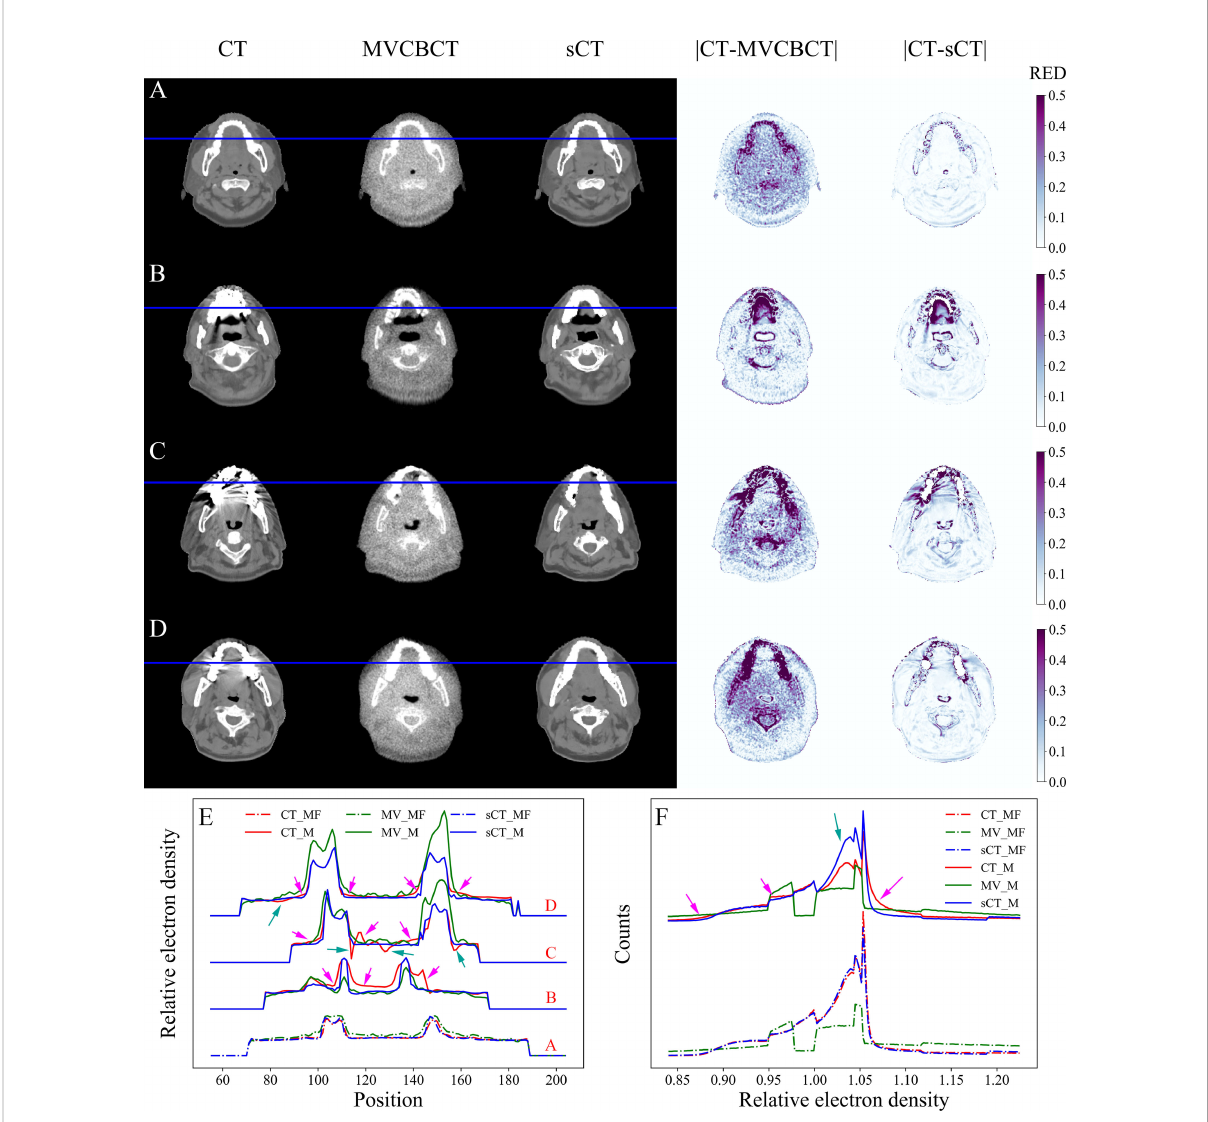
FIGURE 3 RED comparison of CT, MVCBCT and sCT images. (A) Metal-free images. (B-D) Metal-containing images. (E) RED distribution curves for the blue lines in (A – D) . (F) RED histograms of the images. The display window for CT, MVCBCT and sCT images was [-360, 440] HU. The RED distributions of CT_MF and sCT_MF images were almost coincident, and the metal artifacts were completely eliminated in sCT_M images after the MAR